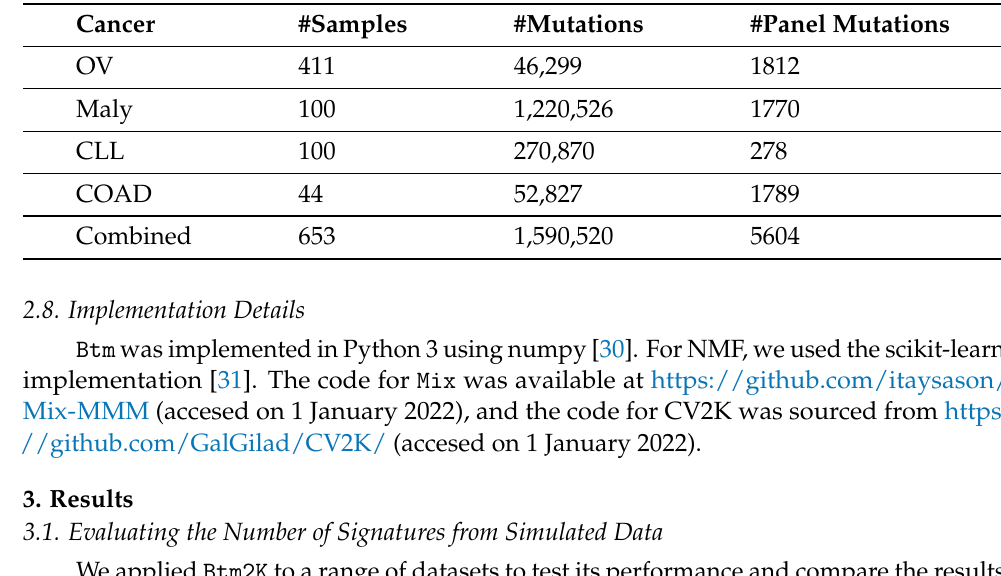
Table 2. Summary of WGS/WXS down-sampled